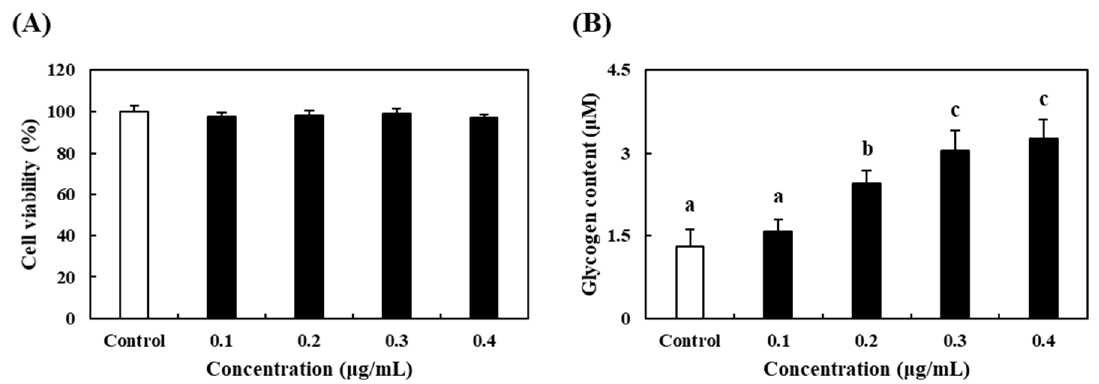
Figure 2. Effects of PV on (A) cell proliferation and (B) glycogen accumulation in C2C12 myoblasts. Data values are expressed as the means ± S.E. ( n = 3). Different letters on the bar are significantly different ( p < 0.05).